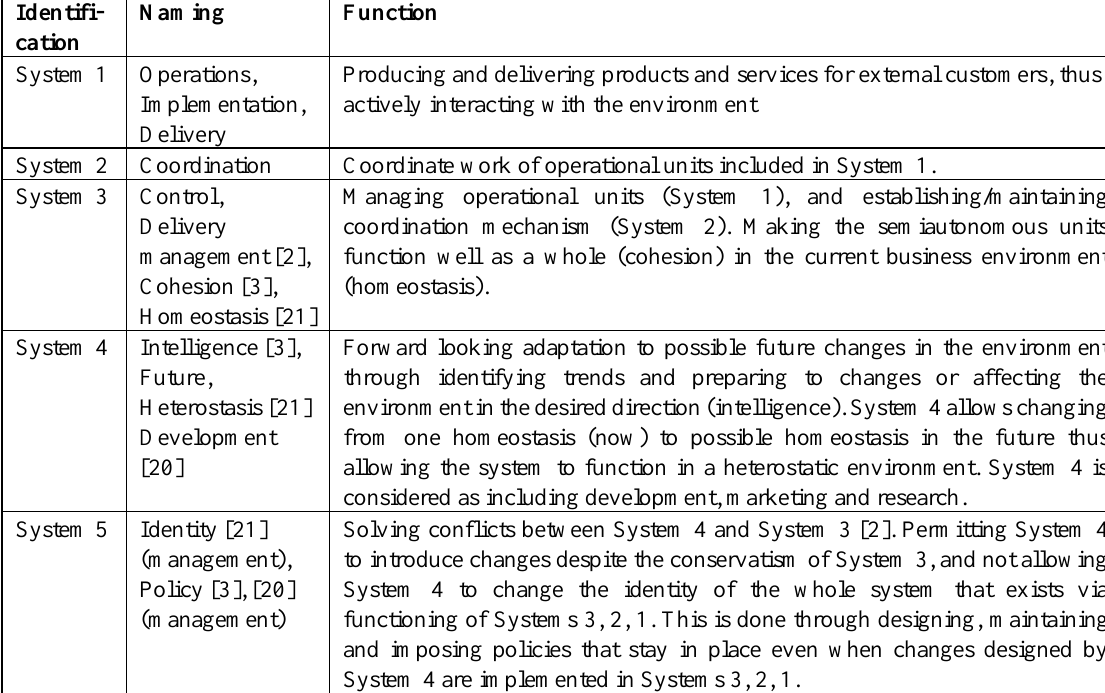
Table 1. Components of